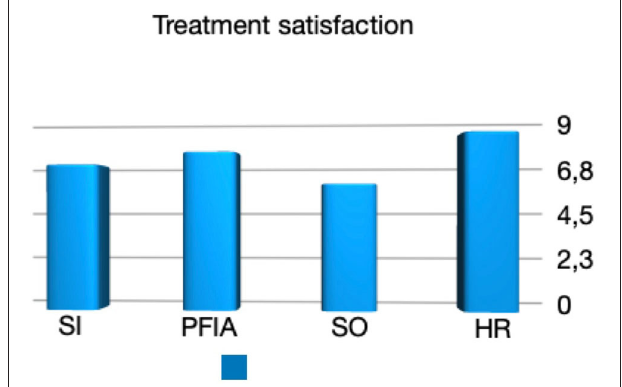
FIGURE 4 | Parents or Caregivers treatment